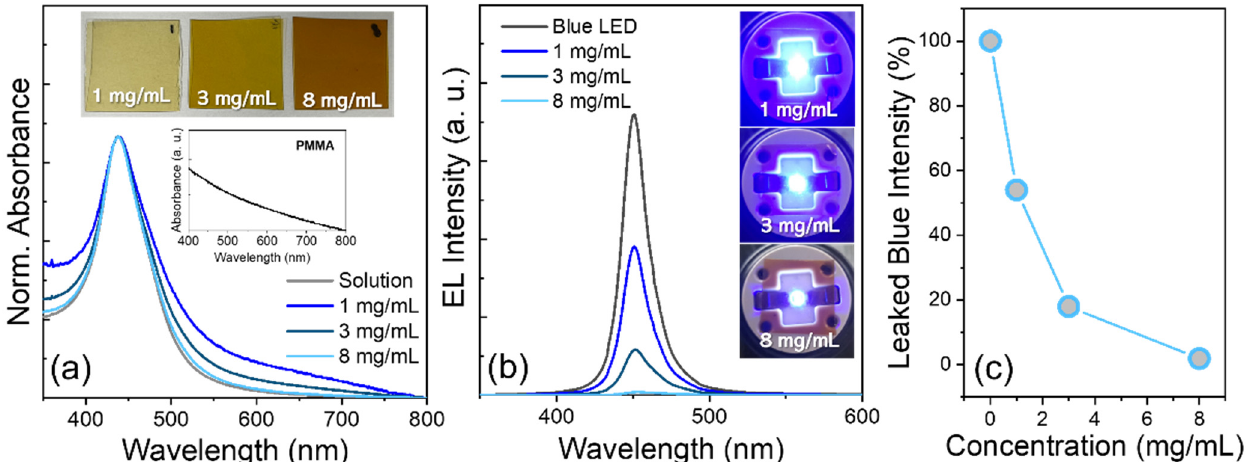
Figure 3. Comparison of ( a ) normalized absorption spectra of Au/Ag = 0.45-based AuAg NPs in solution (dispersion in chlorobenzene) and PMMA matrix film with different concentrations of AuAg NPs. The absorption spectrum of pure PMMA film is included in the inset. ( b ) EL spectra of 5 mA-driving blue LEDs without and with AuAg NP-PMMA films having different AuAg NP concentrations and ( c ) the corresponding leaked blue light intensity as a function of AuAg NP concentration.